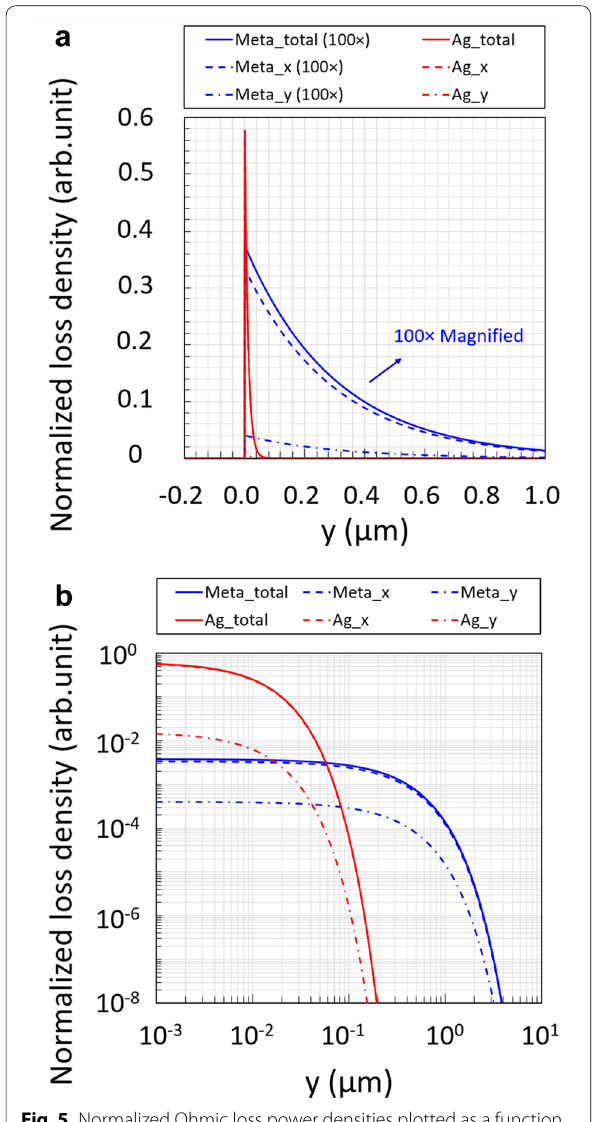
Fig. 5 Normalized Ohmic loss power densities plotted as a function of distance ( y ) from interface. a Linear-scale plots. Glass side is y < 0. (red) Ag/glass. (blue) Metamaterial ( f 0.1)/glass. (solid) Total loss = density. (dashed) Contribution by tangential electric field. (dash-dot) Contribution by normal electric field. Note that metamaterial losses are 100 magnified. b Log–log scale ×